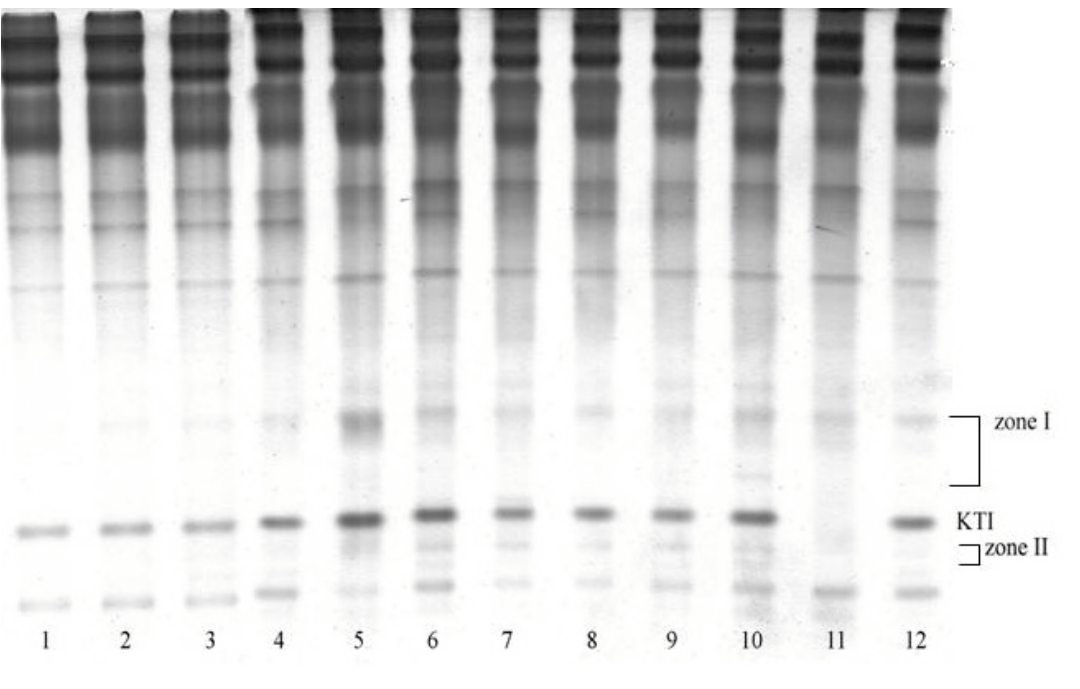
Figure 1. PAGE analysis of the protein extracts. Lanes 1-12 represent the electrophoretic patterns of the Proteinka, Balkan, Ravnica, Vojvodjanka, Krajina, SG1-1, L94-117, L91- 31022, Nena, ZPS-015, Lana and Novosadjanaka genotypes,